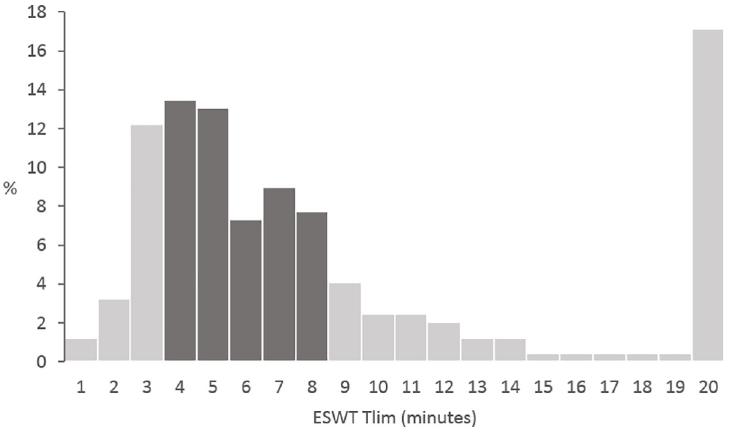
Fig 2. The distribution of patients according to the ESWT Tlim per